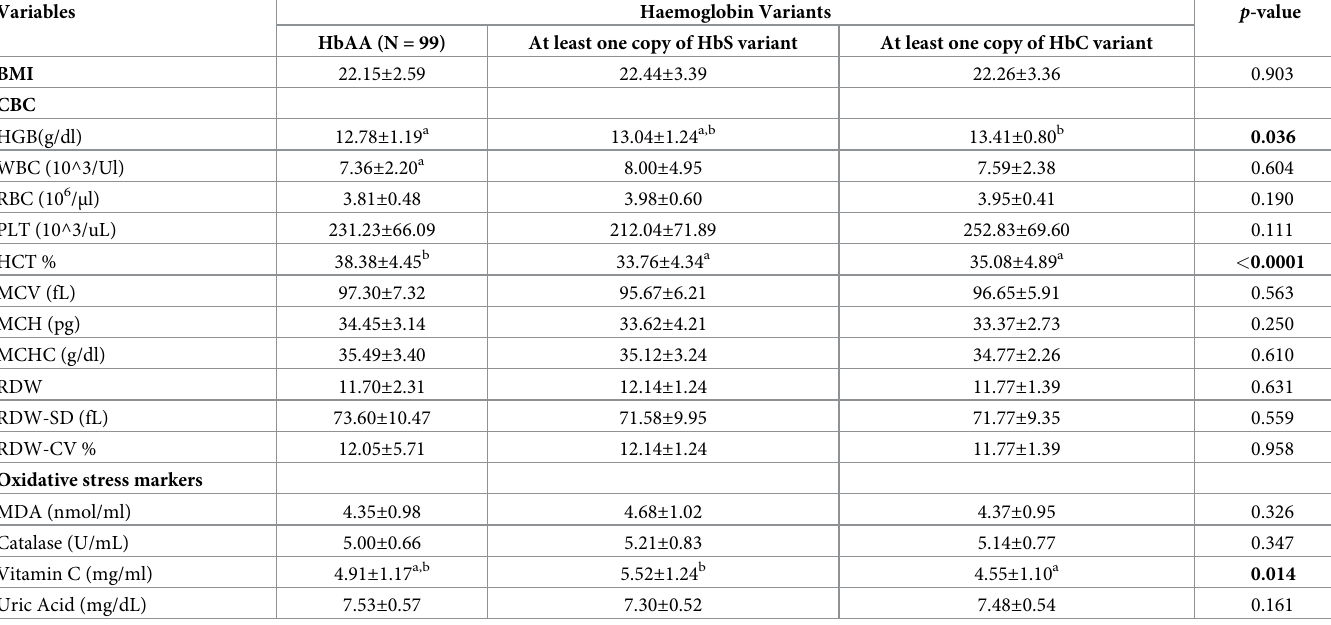
Table 3. Distribution of haematological and oxidative stress markers across the three dominant haemoglobin variants. Variables Haemoglobin Variants p -value HbAA (N = 99) At least one copy of HbS variant At least one copy of HbC